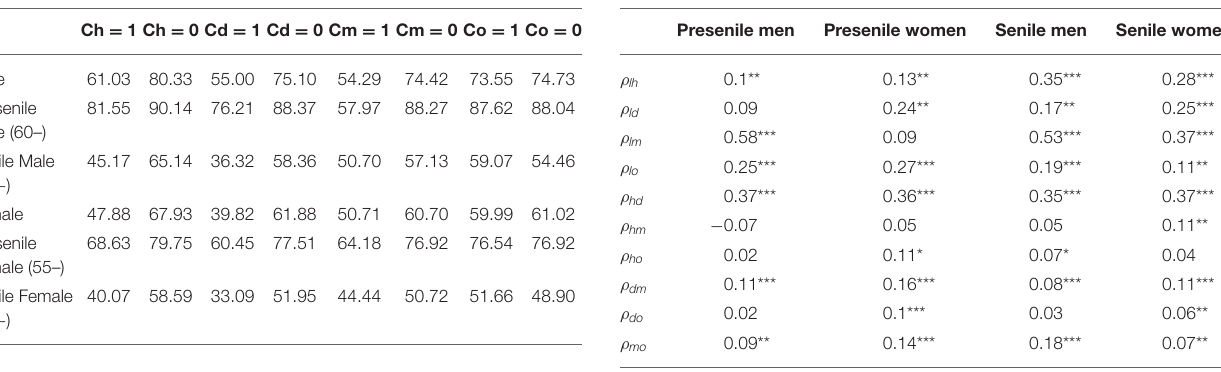
TABLE 3 | The labor force participation of each chronic disease (%). TABLE 4 | Estimated correlation coefficients of a multivariate probit (MVP) model.